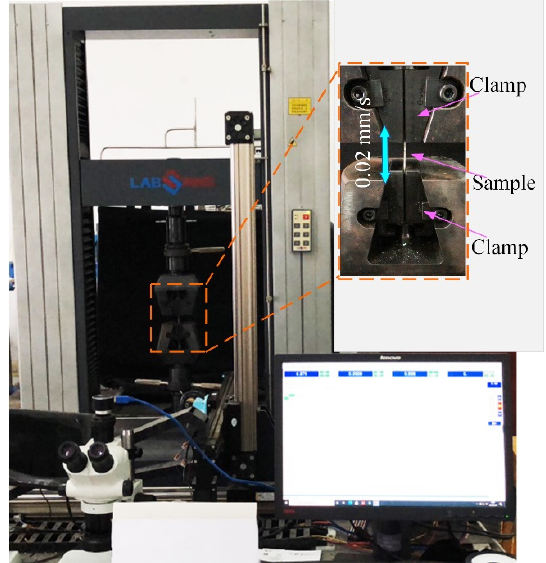
Figure 4. The tensile equipment and test parameters.